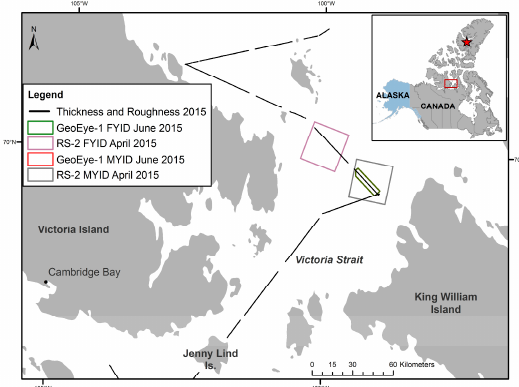
Figure 2. Map of study area located in the CAA depicting the locations of RADARSAT-2 (RS-2) image acquisitions shown in purple and gray for FYI-dominated (FYID) and MYI-dominated (MYID) areas respectively. Corresponding GeoEye-1 optical image coverages for FYID are shown in green and MYID zone are shown in red. The track of airborne winter snow plus sea ice thickness and surface roughness point measurements is shown in black. The location of in situ snow depth measurements is shown by a red star in the outset map.